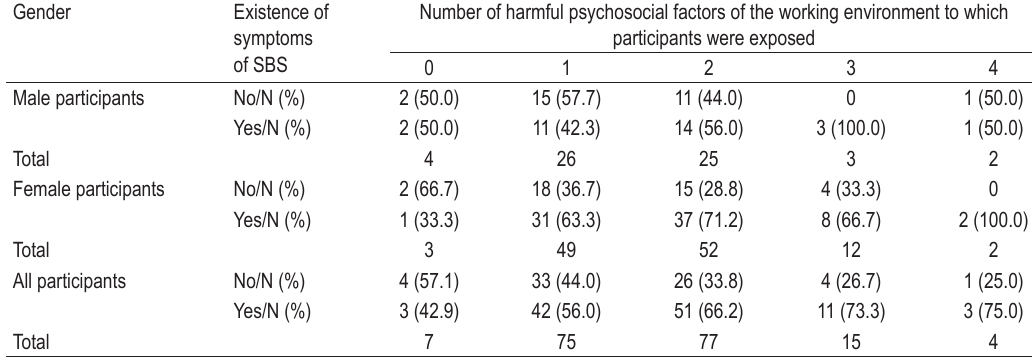
TABLE 1. Participants according to the gender and existence of symptoms of SBS and according to the exposure to a various number of harmful psychosocial factors of the working environment